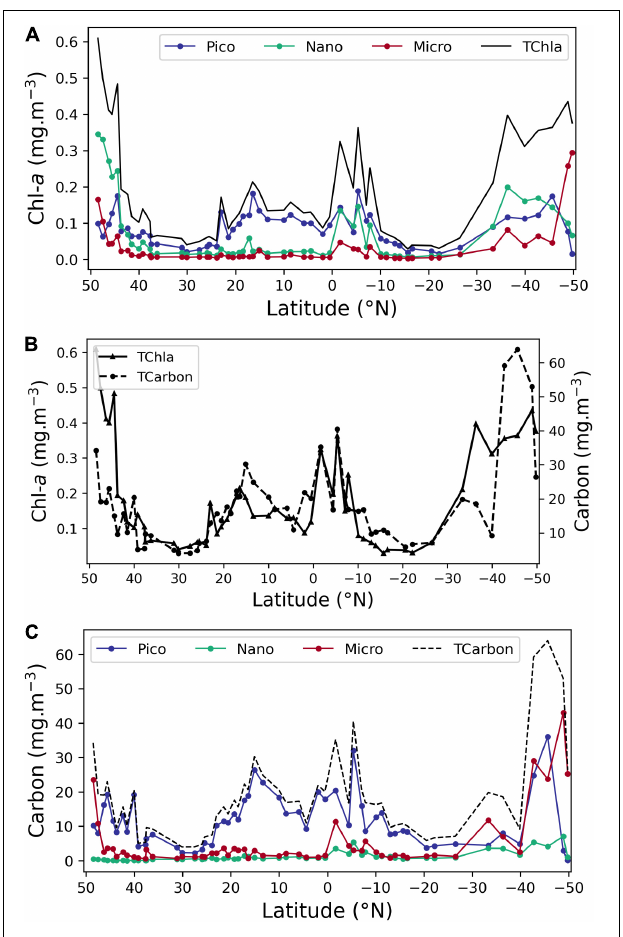
FIGURE 6 | Distribution of size classes pico-, nano-, and microplankton obtained by pigment (determined by pigments’ concentration) and carbon approaches (determined by cell enumeration). (A) Chl a concentration (mg Chl a m − 3 ) observed along the transect using the pigment approach for the pico-, nano-, and microplankton, as well as Total Chl a . (B) Total Chl a and total carbon (mg m − 3 ); (C) mg carbon m − 3 for 3 size classes pico-, nano-, and microplankton, as well as total carbon. Note that total carbon values in (B) and nano-values in (C) north of 37 ◦ N are underestimated due to the lack of NEUK FC